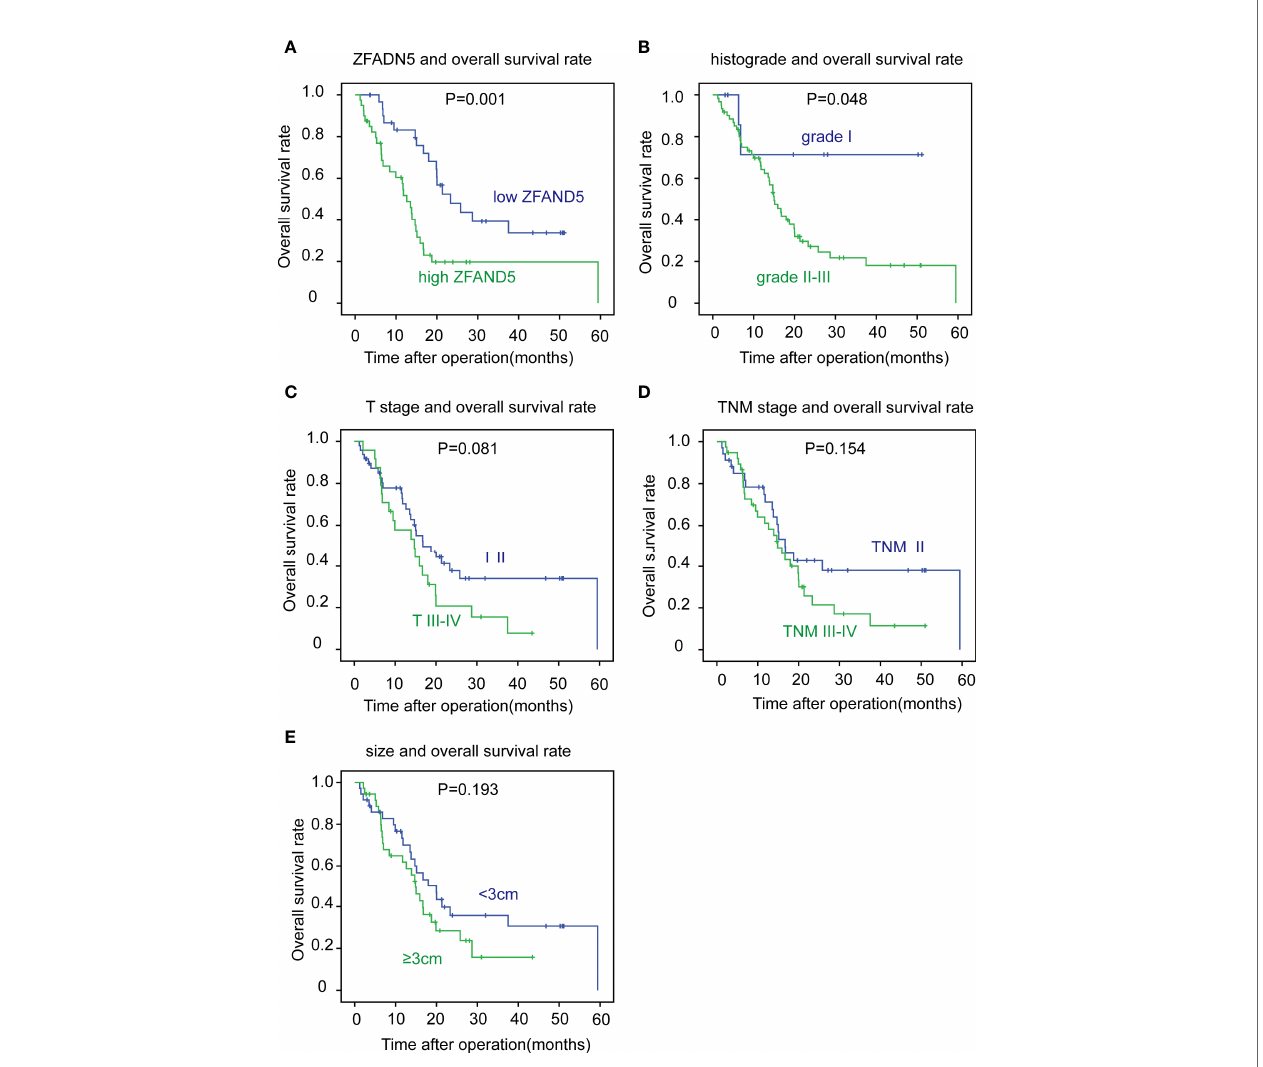
FIGURE 3 | The correlation between clinicopathological factors and overall survival rates. The patients were divided into different subsets according to ZFAND5 expression (A) , histological grade (B) , T stage (C) , TNM stage (D) and tumor size (E) . The survival curves were plotted by Kaplan-Meier method, and the statistical signi fi cance was analyzed with the log-rank